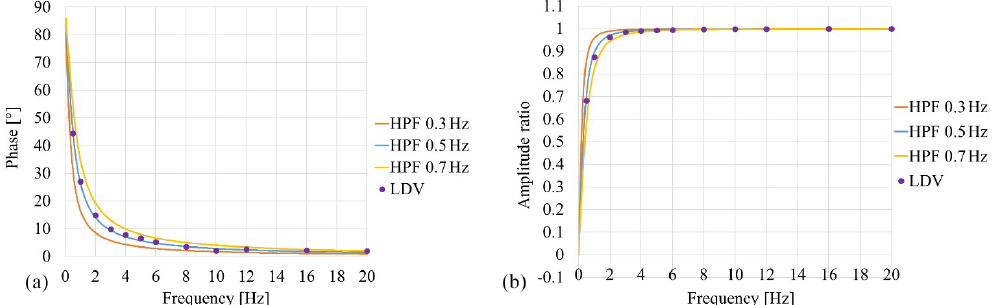
Figure 5. Comparison between phase theoretical curves of a first-order high-pass filter (HPF) with cut-off frequency in the range 0.3–0.Hz and experimental data for (a) phase and (b) amplitude.